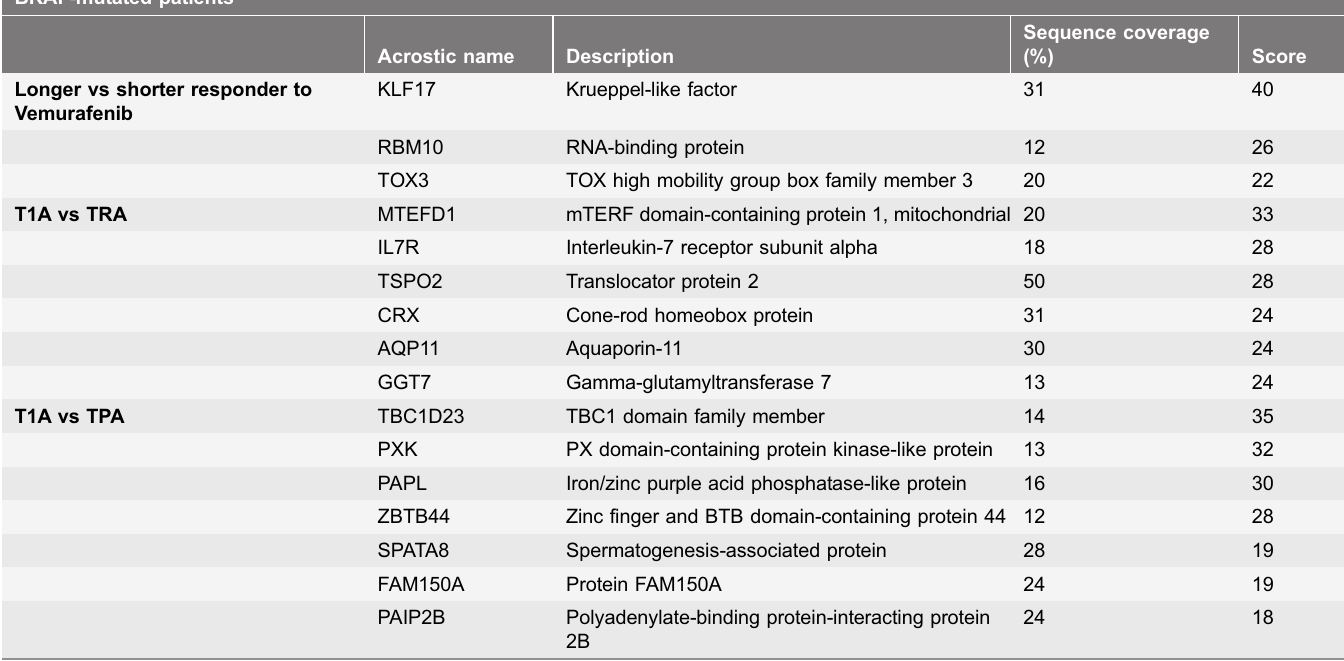
Table 7. Mascot search result for BRAF mutated patients. BRAF-mutated